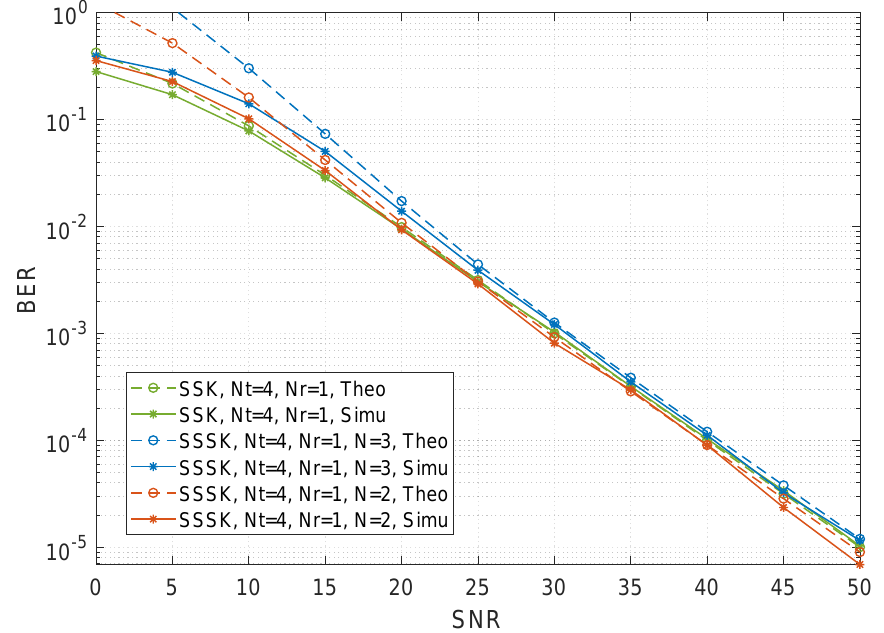
Figure 2. Performance comparisons between the sparse SSK for different values of N and conventional SSK having N t = 4 and N r = 1 at 2